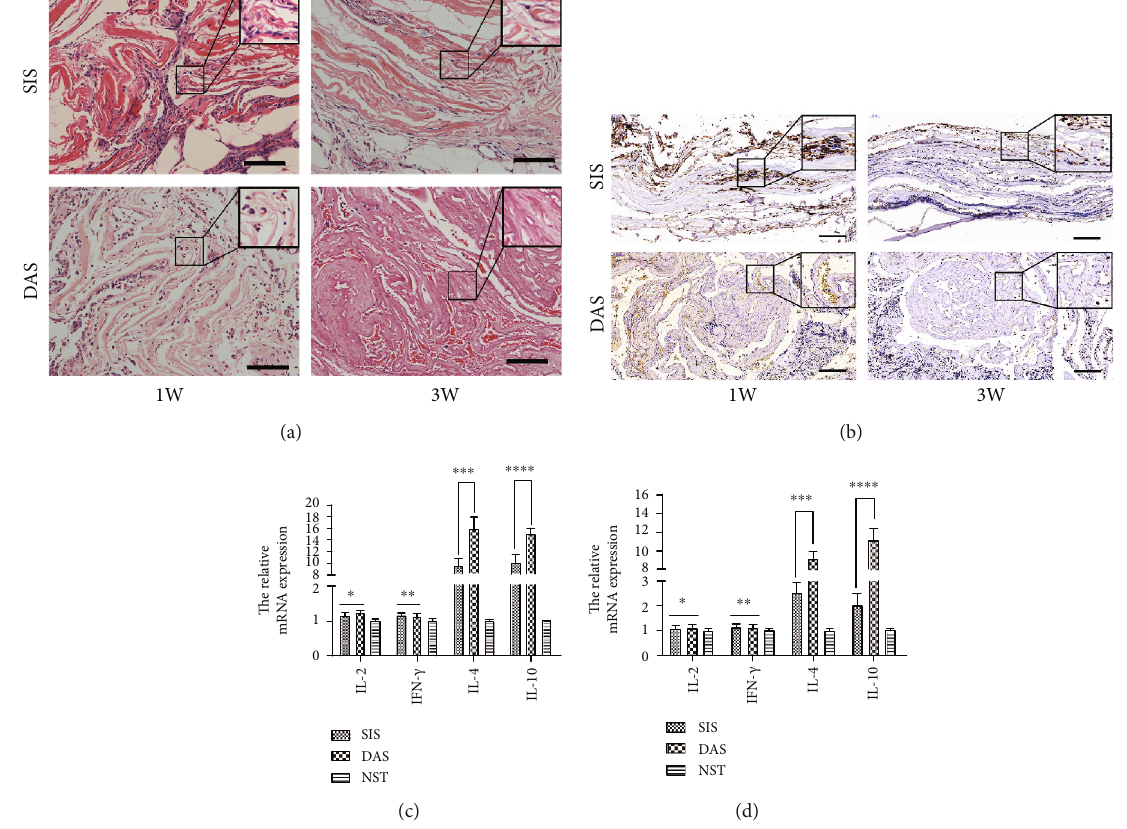
Figure 5: In vivo evaluation of immune rejection and in fl ammatory response to ECM sca ff olds. (a) H&E staining showing host response to decellularized ADSC sheets and xenogenic SIS at 1 week and 3 weeks after implantation. The decellularized ADSC sheets induced much less in fl ammation than xenogenic SIS during 3 weeks and showed less mononuclear cells and neutrophil granulocyte in fi ltrating. The black box represents a high magni fi cation photograph (400x) to appreciate the cellularity of implants. Scale bars are of 100 μ m. (b) The percentage of CD68+ cells in SIS transplantation was signi fi cantly higher than that of the decellularized ADSC sheet transplantation at 1 week and 3 weeks after implantation. The number of in fl ammatory CD68+ cells in both groups decreased over time, but in fl ammatory CD68+ cell retrogression is more obvious in the decellularized ADSC sheet transplantation. The black box represents a high magni fi cation photograph of CD68+ cells. Scale bars are of 100 μ m. (c) The mRNA expression of multiple cytokines related to immunity and in fl ammation after 1 week in vivo transplantation; IL-2 comparison of SIS vs. DAS ( ∗ P > 0 : 05 ); IFN- γ comparison of SIS vs. DAS ( ∗∗ P > 0 : 05 ); IL-4 comparison of SIS vs. DAS ( ∗∗∗ P < 0 : 05 ); IL-10 comparison of SIS vs. DAS ( ∗∗∗∗ P < 0 : 05 ). (d) The mRNA expression of multiple cytokines related to immunity and in fl ammation after 3 weeks in vivo transplantation; IL-2 comparison of SIS vs. DAS ( ∗ P > 0 : 05 ); IFN - γ comparison of SIS vs. DAS ( ∗∗ P > 0 : 05 ); IL-4 comparison of SIS vs. DAS ( ∗∗∗ P < 0 : 01 ); IL-10 comparison of SIS vs. DAS ( ∗∗∗∗ P < 0 : 01 ). DAS=decellularized ADSC sheets; SIS =small intestinal submucosa; NST =normal subcutaneous tissue. The dog GAPDH was chosen as the reference gene for quantitative real-time